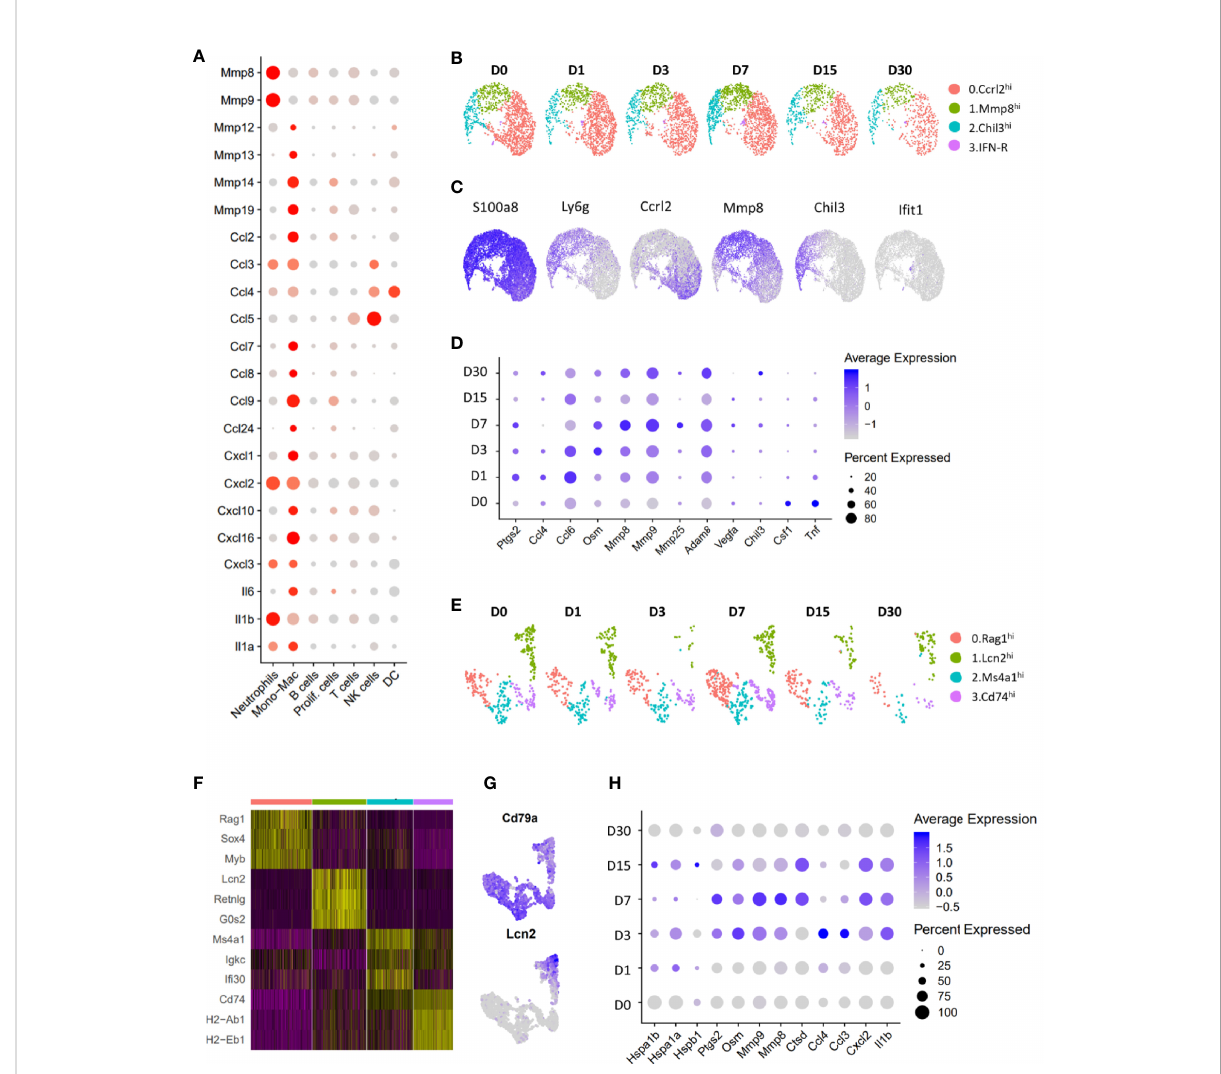
FIGURE 8 Characterization of neutrophils and B lymphocytes. (A) Dot plot showing the expression of cytokines and proteases in various immune cell clusters. Dot size represents the fraction of cells expressing a speci fi c marker while the intensity of color indicates the average expression level for each gene (grey: low expression; red: high expression). (B) UMAP plot showing various neutrophil sub-clusters. (C) Feature plot showing the expression of various neutrophil sub-cluster markers as well as pan-neutrophil marker S100a8. (D) Dot plot showing genes differentially expressed in neutrophils after injury. Dot size represents the fraction of cells expressing a speci fi c marker while the intensity of color indicates the average expression level for each gene. (E) UMAP plot showing various B cell sub-clusters. (F) Heatmap showing genes enriched in each B cell subtype. (G) Feature plot showing the expression of Lcn2 and B cell marker Cd79a in B cell subtypes. (H) Genes differentially expressed in Lcn2 hi B cell-like cells after injury. Dot size represents the fraction of cells expressing a speci fi c marker while the intensity of color indicates the average expression level for each